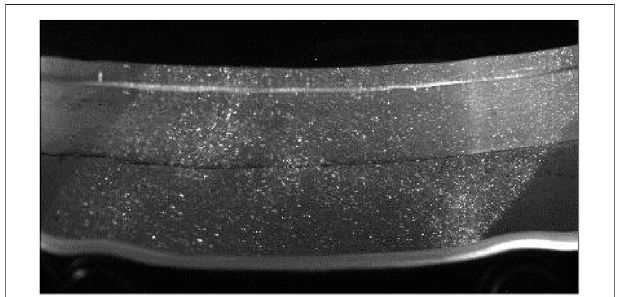
TABLE 5 | Table of test bed